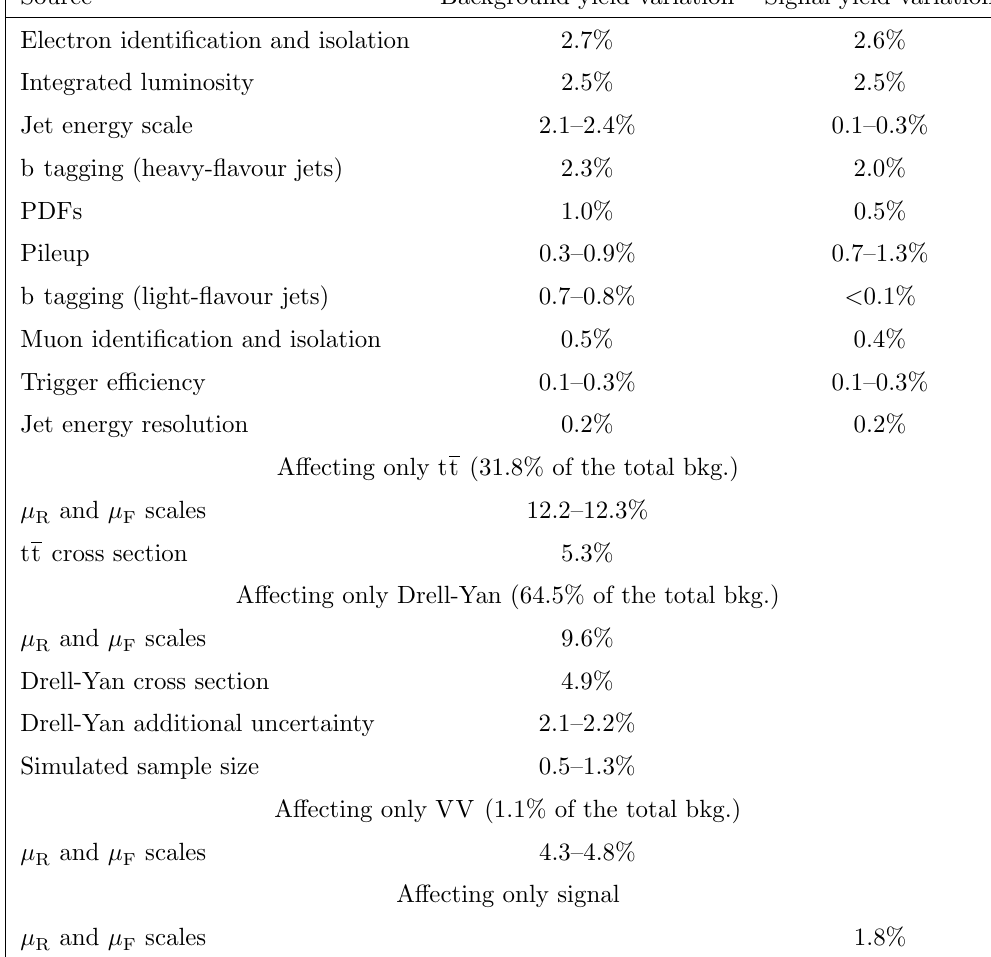
Table 2 . Summary of the systematic uncertainties prior to the (cid:12)t and the variation, in percentages, that they induce on the total event yields for the dominant background and signal processes, under a particular signal hypothesis with m = 379 GeV and m = 172 H A